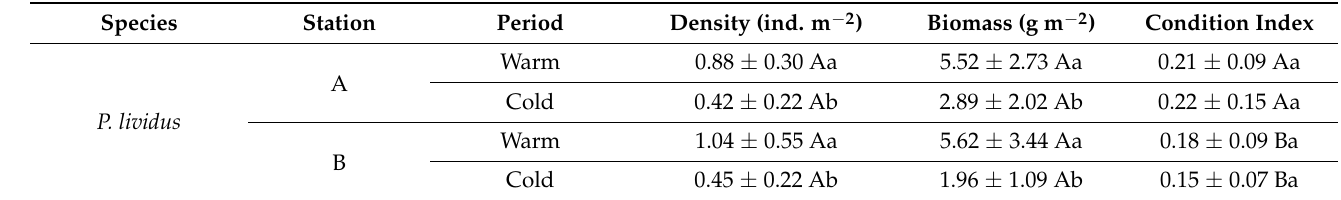
Table 3. Average values of P. lividus biometric measurements for the two stations over the cold and warm periods. Values are X ± SE ( n = 30). The significant differences ( p ≤ 0.05) between stations are represented by capital letters and between seasons by small letters.